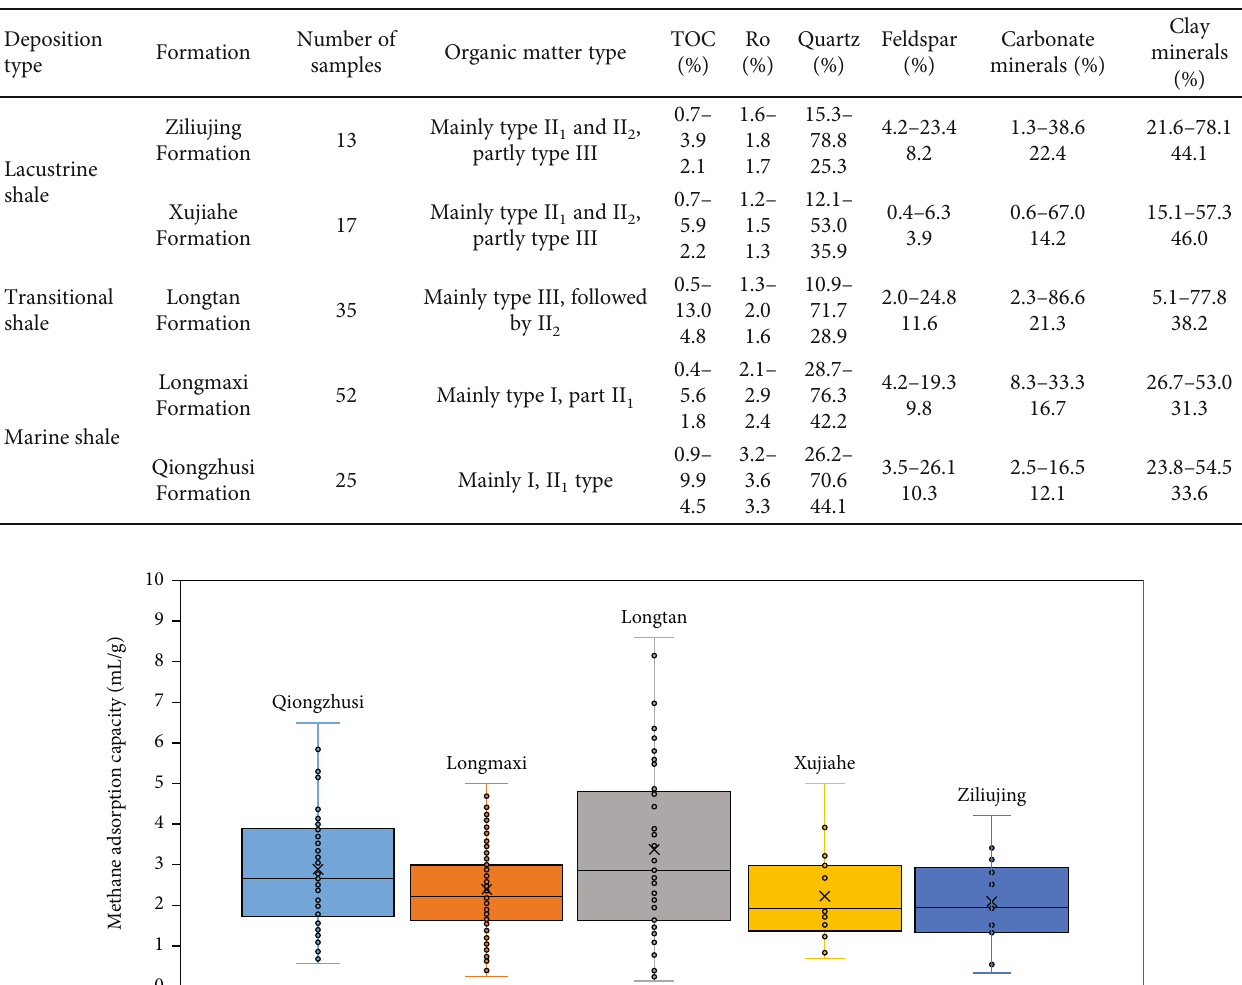
Table 1: Characteristics of shale in di ff erent formation in the Sichuan Basin.